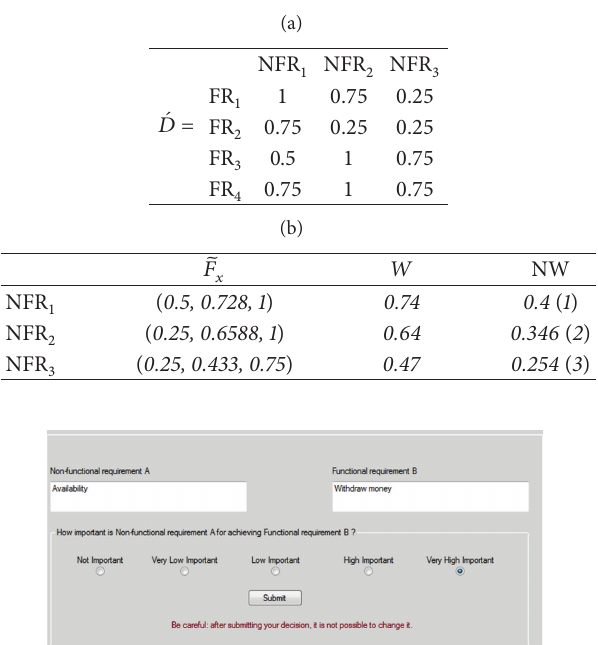
Table 4: Example of computing NFRs priority vector with respect to all FRs.